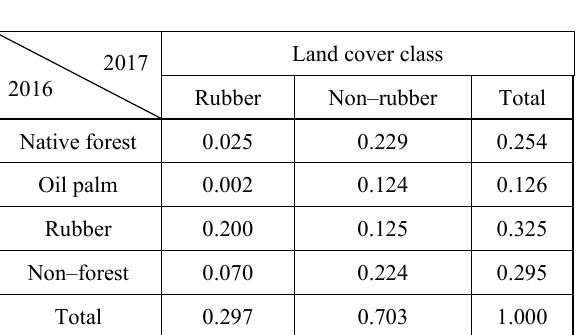
Table 1. Land cover changes map probability for 2016–2017.